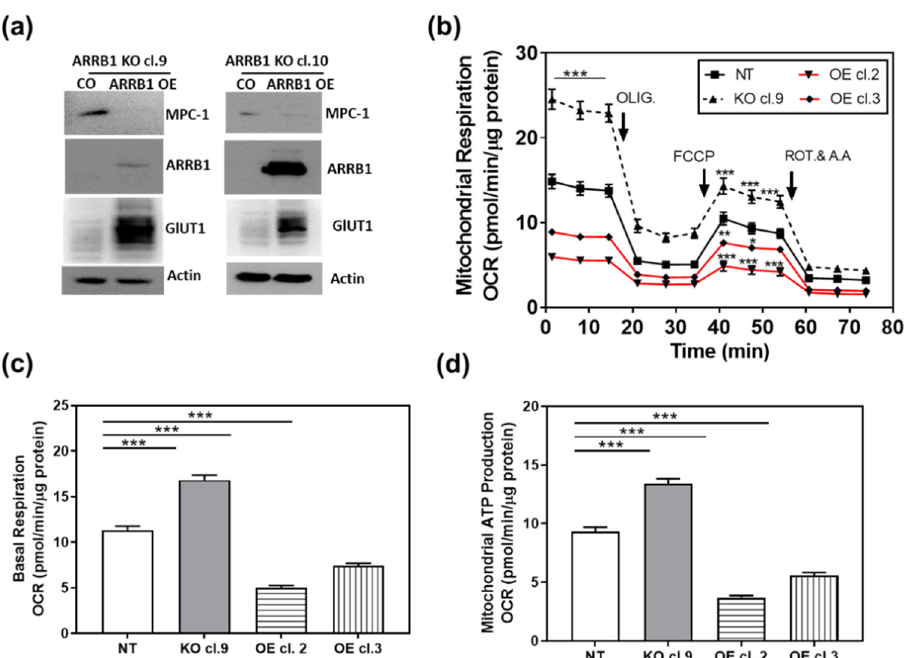
Figure 5. Re-expression of ARRB1 in ARRB1 depleted cells restores the metabolic program: ( a ) HT1376 ARRB1 KO cells (KO cl. 9 and KO cl. 10) were transfected with ARRB1 for re-expression/overexpression (OE) of ARRB1. Protein extracts were isolated for detection of ARRB1 and MPC1 by Western blot analysis. ( b ) ARRB1 KO cells (KO cl. 9) were transfected with ARRB1, and stable clones overexpressing ARRB1 were generated (OE cl.2 and cl.3). The Metabolic preference of clones was analyzed by measuring the oxygen consumption rate. Data: means ± SEM, n = 8; *** p < 0.001, ** p < 0.01,* p < 0.05 (two-way ANOVA). ( c , d ) Basal respiration and mitochondrial ATP production in clones generated following re-expres- sion/overexpression of ARRB1. Data: means ± SEM, n > 10; *** p < 0.001 (one-way ANOVA).